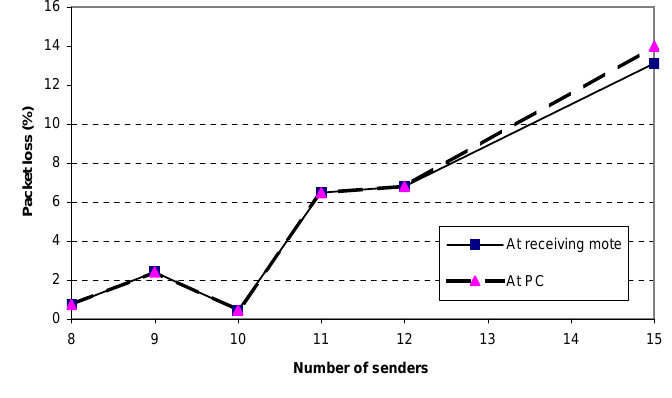
Figure 10. Packet loss at receiving mote and PC as a function of the number of senders (sending rate = 4 packets/sec).